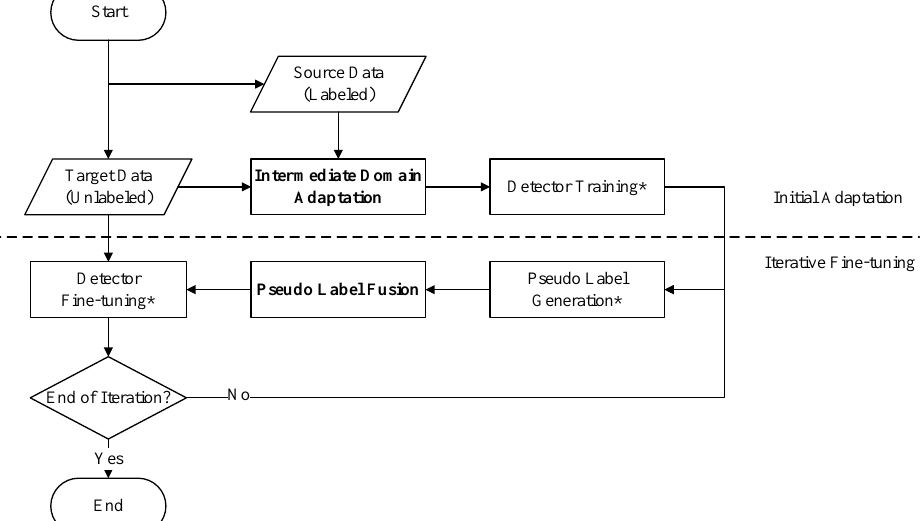
Figure 3. The flow chart of our proposed framework. The main unsupervised adaptation process is divided into two steps: initial adaptation and iterative fine-tuning. In the first stage, the intermediate visible and thermal images are generated by mimicking the target domain style. The initial adaptation is performed by training a detector using the intermediate data with source labels. In the second stage, pseudo labels of the target data generated by both multispectral and auxiliary single-modality (i.e., visible and thermal) detectors, are fused via an illumination-aware mechanism. The iterative fine-tuning process is adopted to converge the detector on the target domain progressively. A block marked with “*” means that the operation is performed for both multispectral and auxiliary